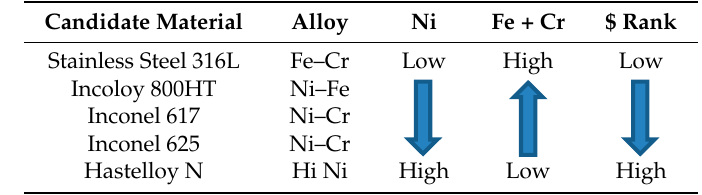
Figure 2. A sample container for compatibility testing.